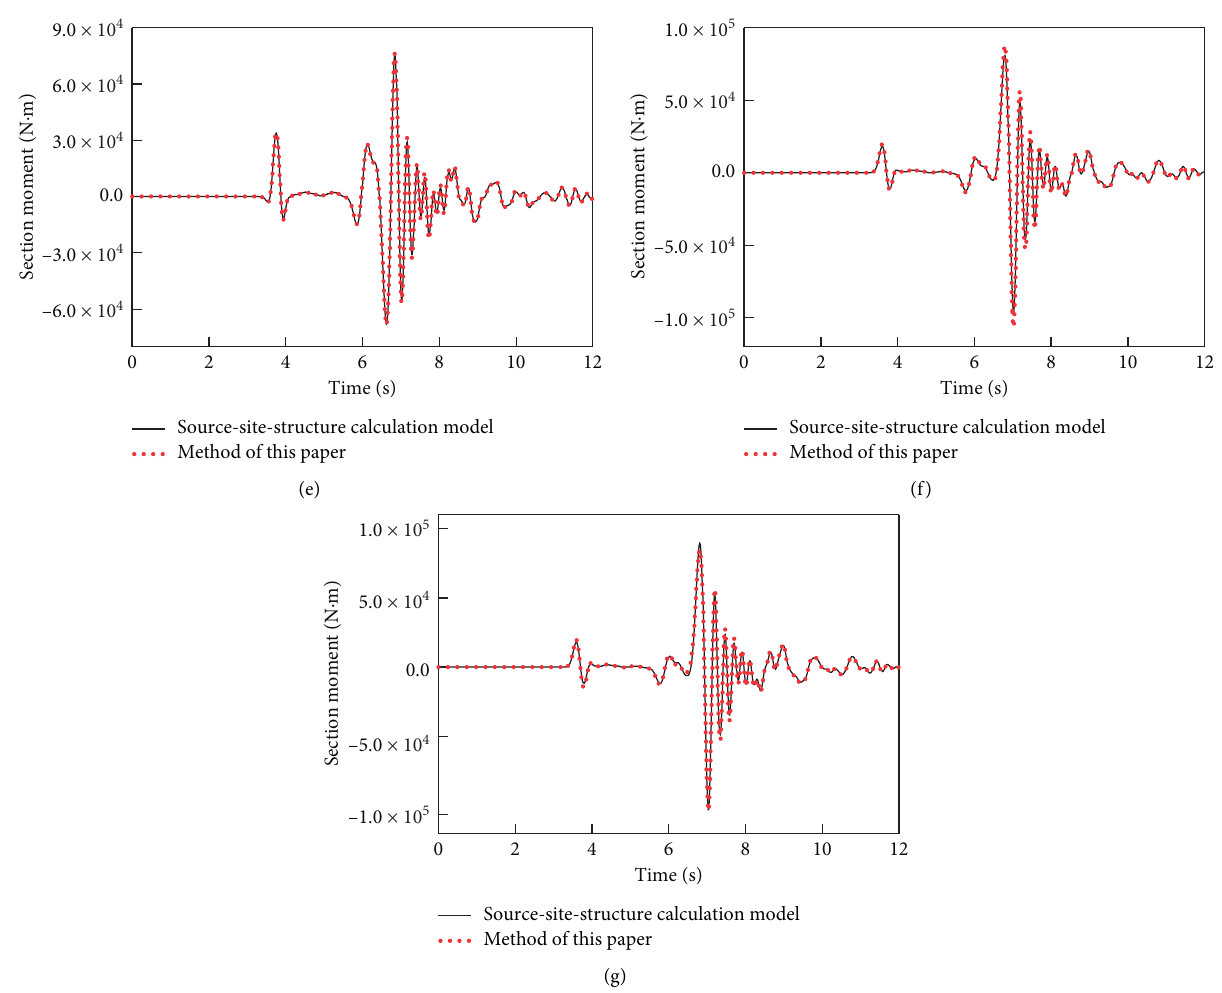
Figure 22: Moment history of the section for different depths: (a) section A (depth is 50m), (b) section B (depth is 100m), (c) section C (depth is 200m), (d) section D (depth is 300m), (e) section A (depth is 400m), (f) section B (depth is 500 m), and (f) section A (depth is 600m).